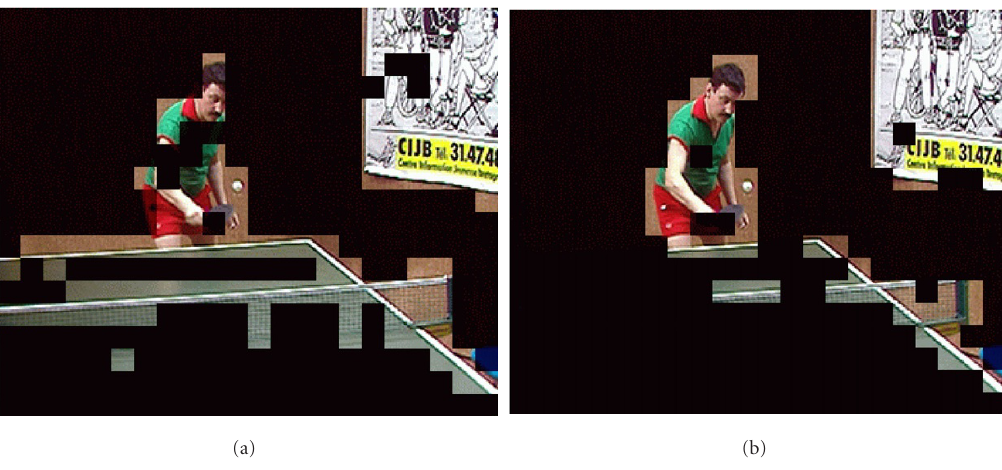
Figure 8: Visualization of block classification using a picture of the “table tennis” sequence. The left (right) picture shows blocks where horizontal (vertical) edges are detected. Blocks that are visible in both pictures belong to the class “diagonal/structured,” while blocks that are blanked out in both pictures are considered as “flat.”